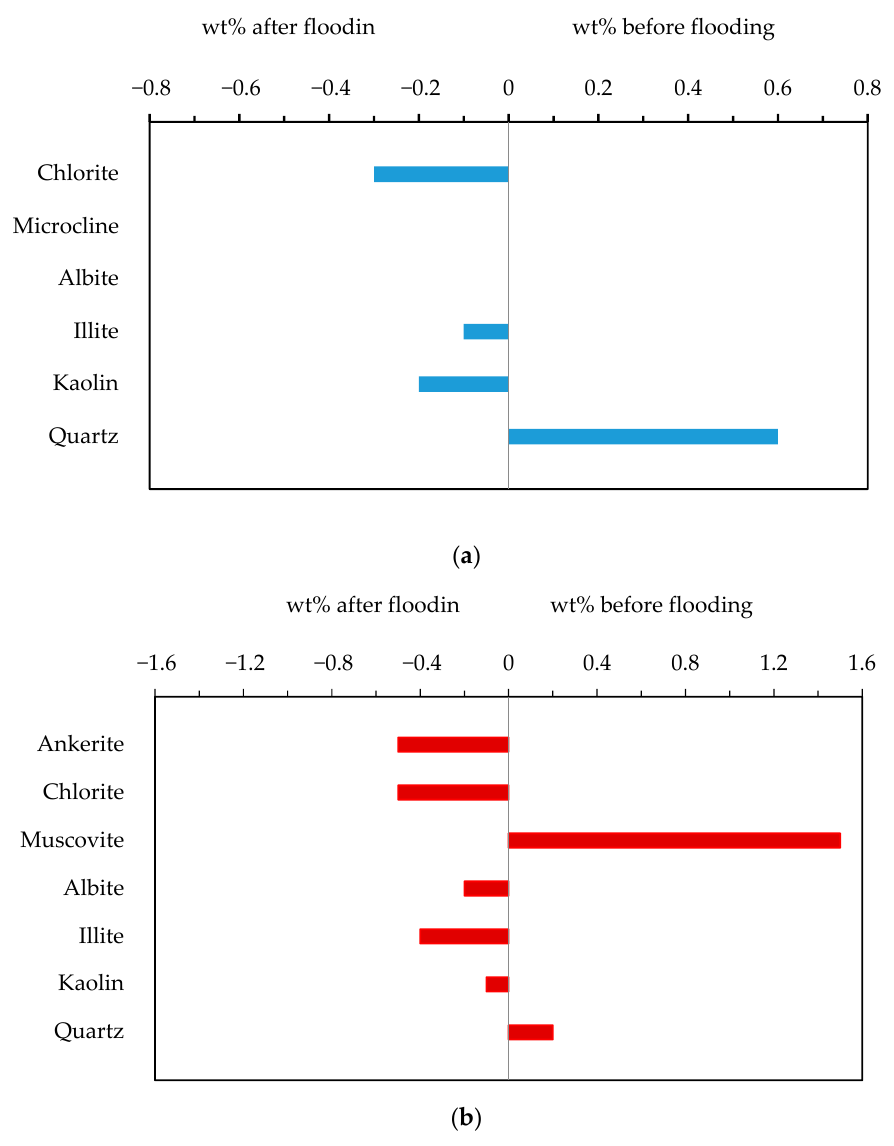
Figure 6. Differences in mineral compositions due to CO 2 flooding in: ( a ) Berea, ( b ) Bandera Gray.